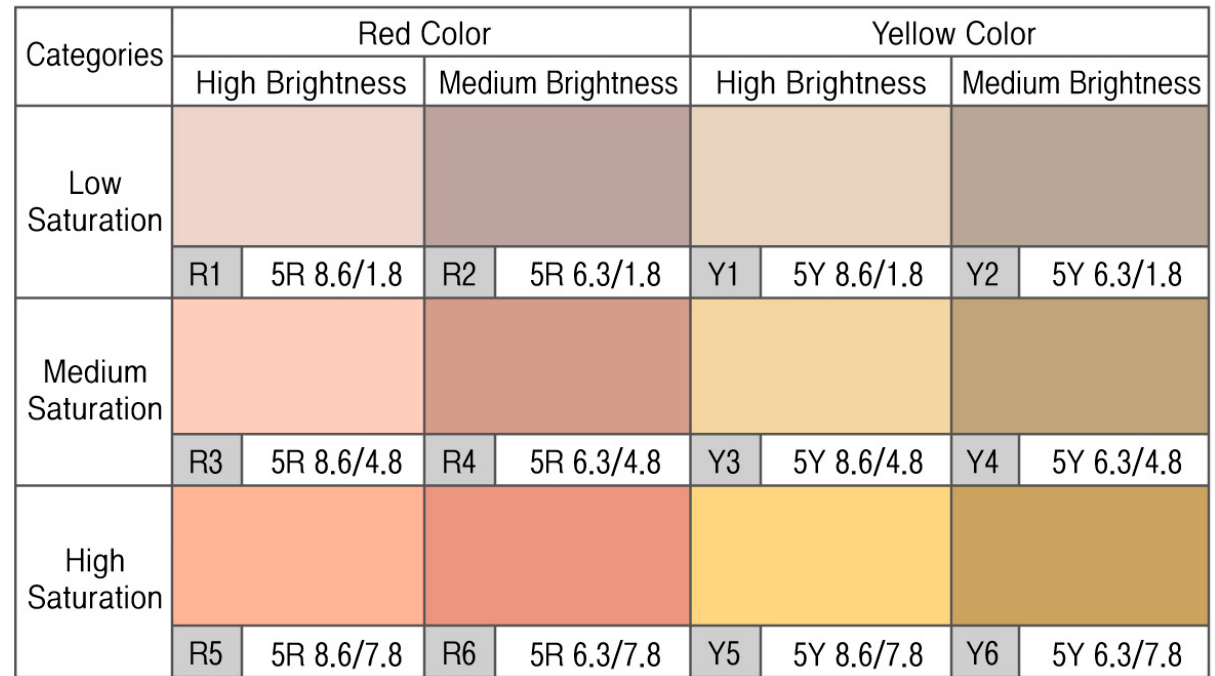
Figure 3. Color samples used for the experiment on the HRV of different stress